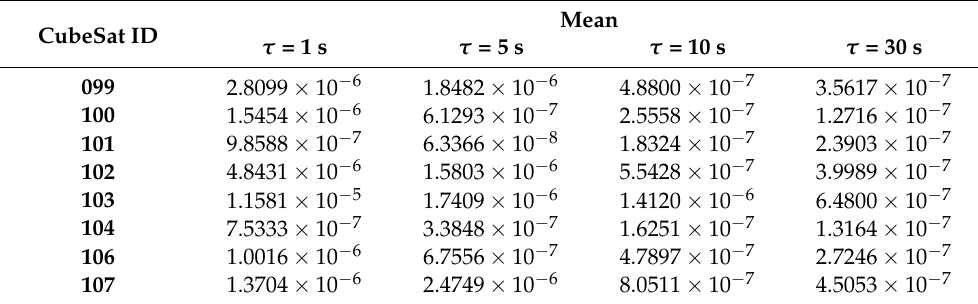
Table 4. Mean values of MDEV differences between when the CubeSats are in the shadow and when they are out of the shadow